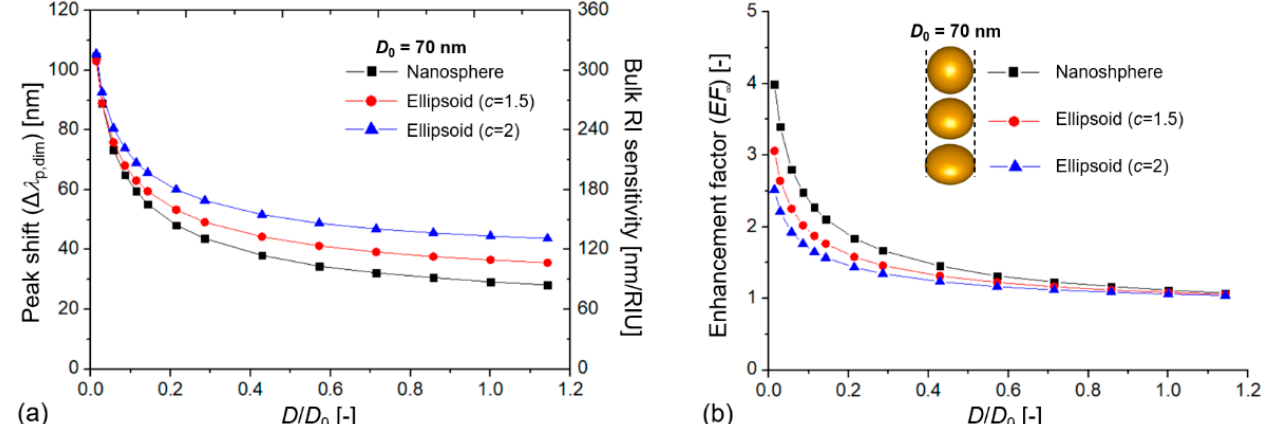
Figure 3. ( a ) Extinction peak shift of coupled plasmonic dimers ( ∆ λ p , dim ) and their calculated bulk refractive index sensitivity (RIS) as a function of the dimensionless D / D 0 value, where D is the interparticle distance, and D 0 is the particle diameter ( D 0 = 70 nm). ( b ) Calculated bulk enhancement factor ( EF ∞ ) values compared to single, uncoupled particles with the same size as a function of D / D 0 .